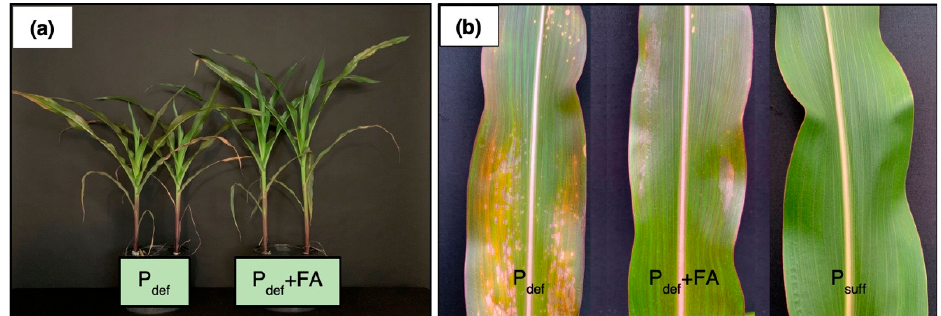
Figure 3. Phenological appearance of maize plants due to their phosphorus nutritional status. ( a ) Comparison of P deficient control plants (P def ) with P deficient plants sprayed with P (P def + FA). ( b ) Comparison of the 5th leaf of P deficient control plants (P def ) with P deficient plants sprayed with P (P def + FA) and with P sufficient control plants (P suff ). Representative plants were selected 14 days after the phosphorus foliar application.